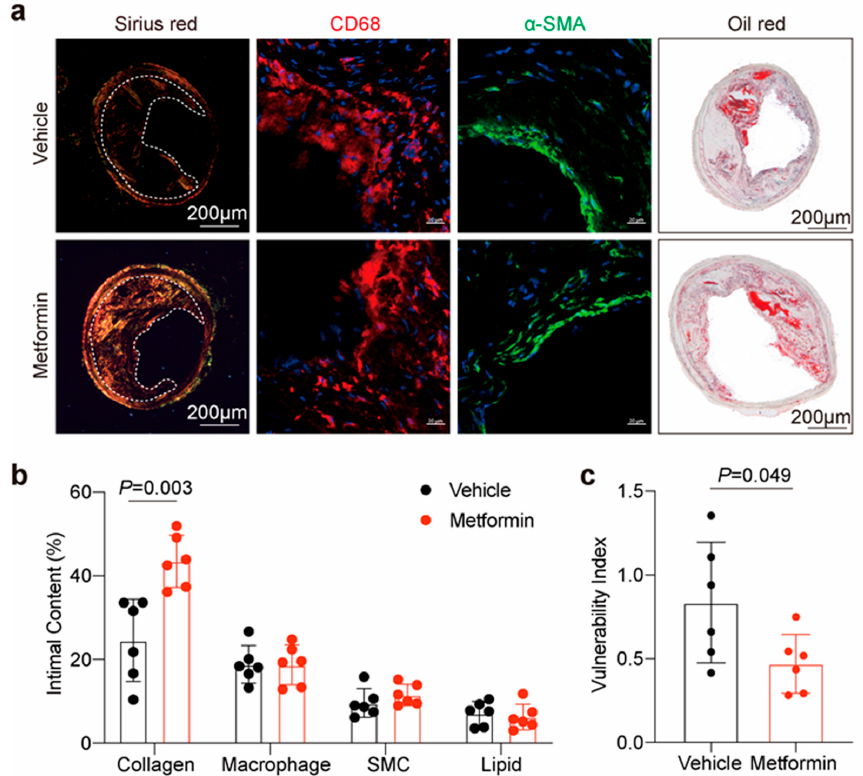
Figure 4. Metformin improves atherosclerotic plaque stability in ApoE-/- mice. ( a ) Representative images of Sirius red staining for plaque collagen, immunostaining for the macrophage marker CD-68, smooth muscle cell marker α -SMA, and oil red O staining for intimal lipid in plaque within the right common carotid artery. Scale bars for Sirius red staining and oil red O staining represent 200 µ m and 20 µ m for immunostaining. ( b ) Quantification of the positive area as a percentage of the whole plaque area. Unpaired Student’s t -test, n = 6 per group. ( c ) The vulnerability index is calculated by dividing the area of macrophage+lipid by that of smooth muscle cells+collagen. Unpaired Student’s t -test, n = 6 per group. Data are presented as the mean ± SD. HFD, high-fat diet; Chol,